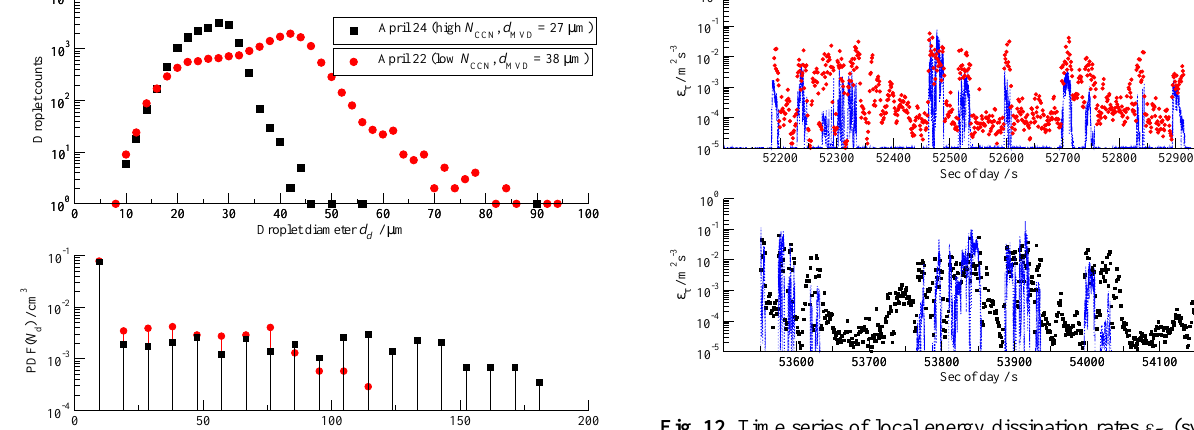
Fig. 12. Time series of local energy dissipation rates ε τ (symbols) with each point representing a one-second average. The dotted blue lines indicate cloud events (unscaled